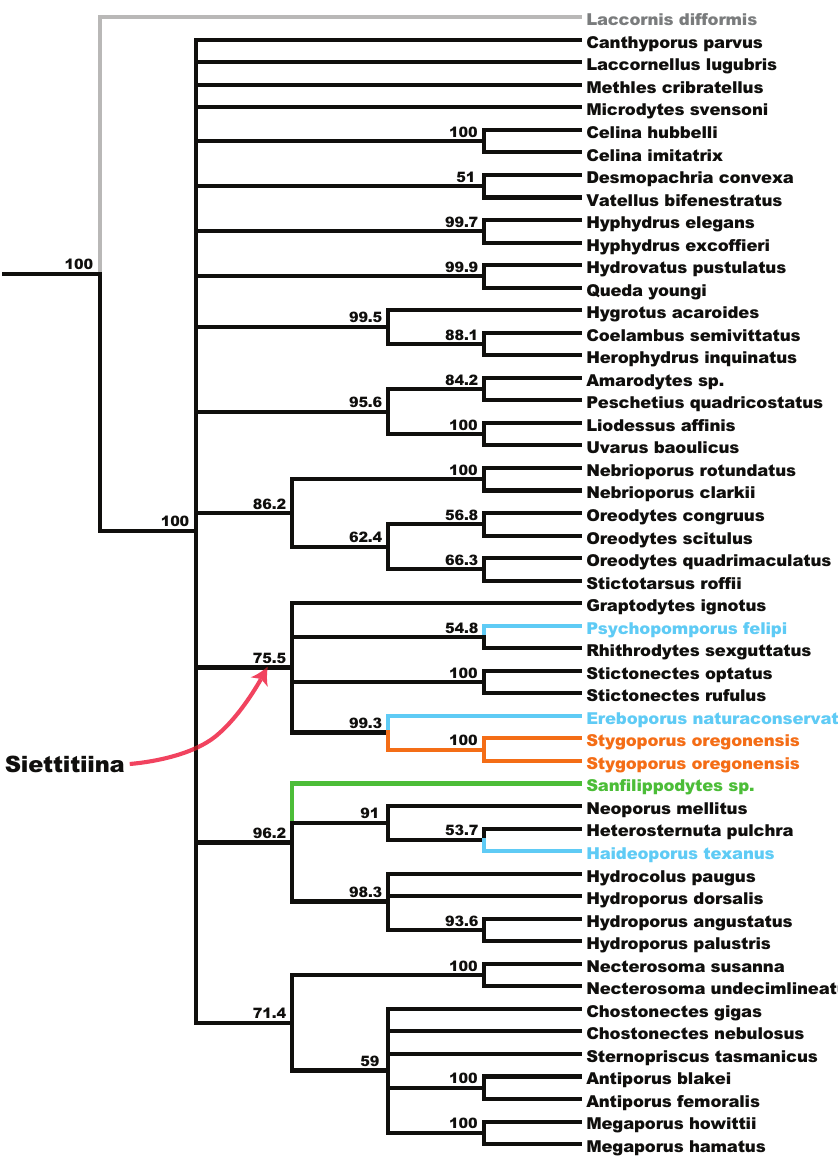
Figure 4. Majority rule consensus of 1,000 bootstrap replicates performed on concatenated dataset. Bootstrap percentages given for clades recovered with more than 50% support. Branches and taxa colored as in Figure